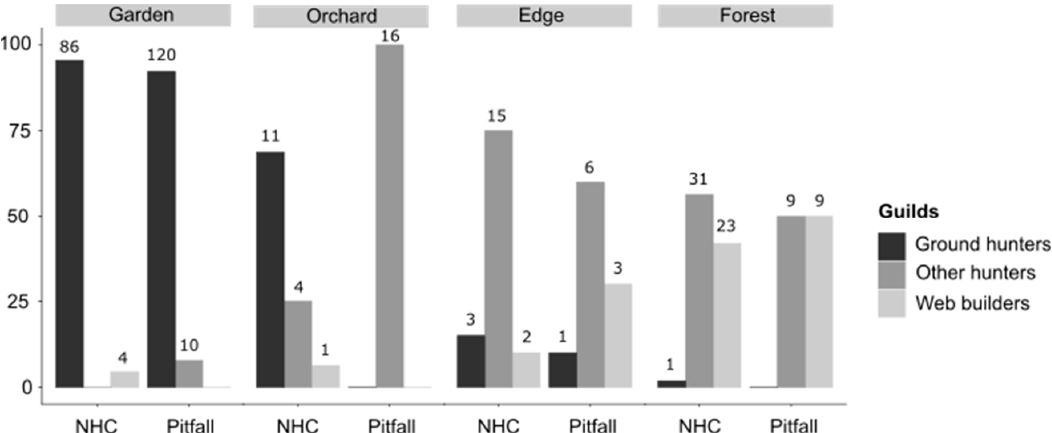
Figure 2. Relative abundance in hunting guilds along the structural gradient of habitats collected by Nocturnal Hand Collecting (NHC) and pitfall traps. For simplification purpose, we grouped guilds as follows: (1) ground hunters: ‘ground hunters’, (2) other hunters regroups the ‘other hunters’, ‘ambush hunters’ and ‘specialists’ guilds, and (3) web builders: ‘sensing-web weavers, ‘sheet-web weavers, ‘space web weavers, and ‘orb-web weavers’. Absolute numbers are presented above each